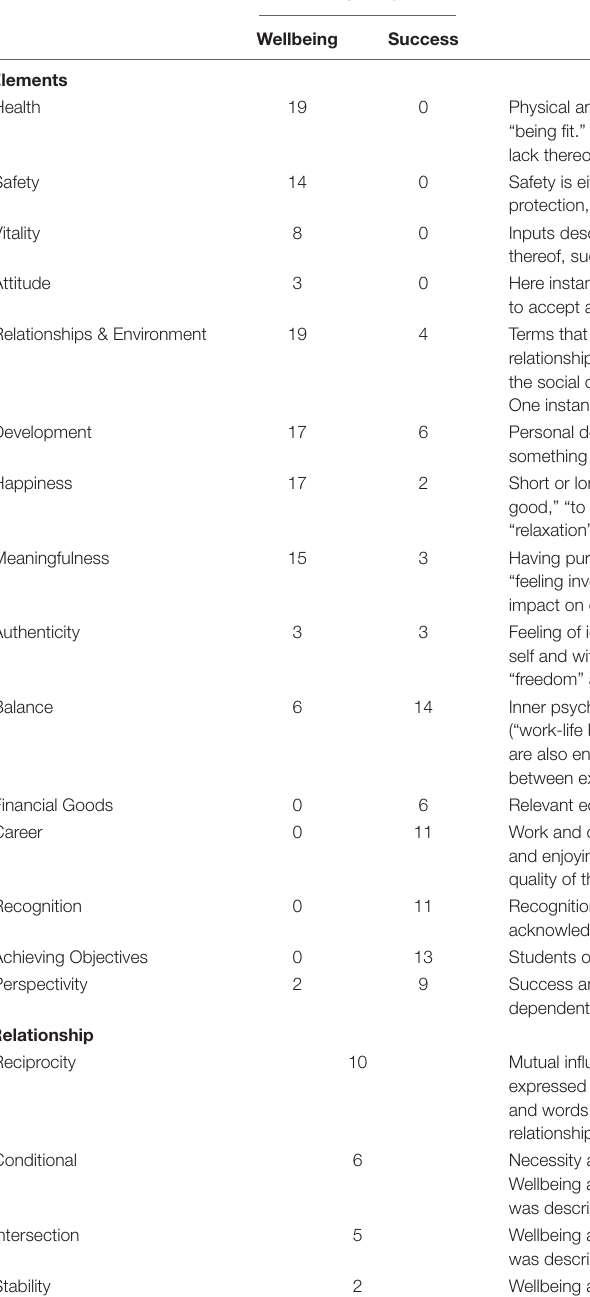
TABLE 3 | Qualitative coding for elements of, and relationship between, wellbeing and success according to music students.